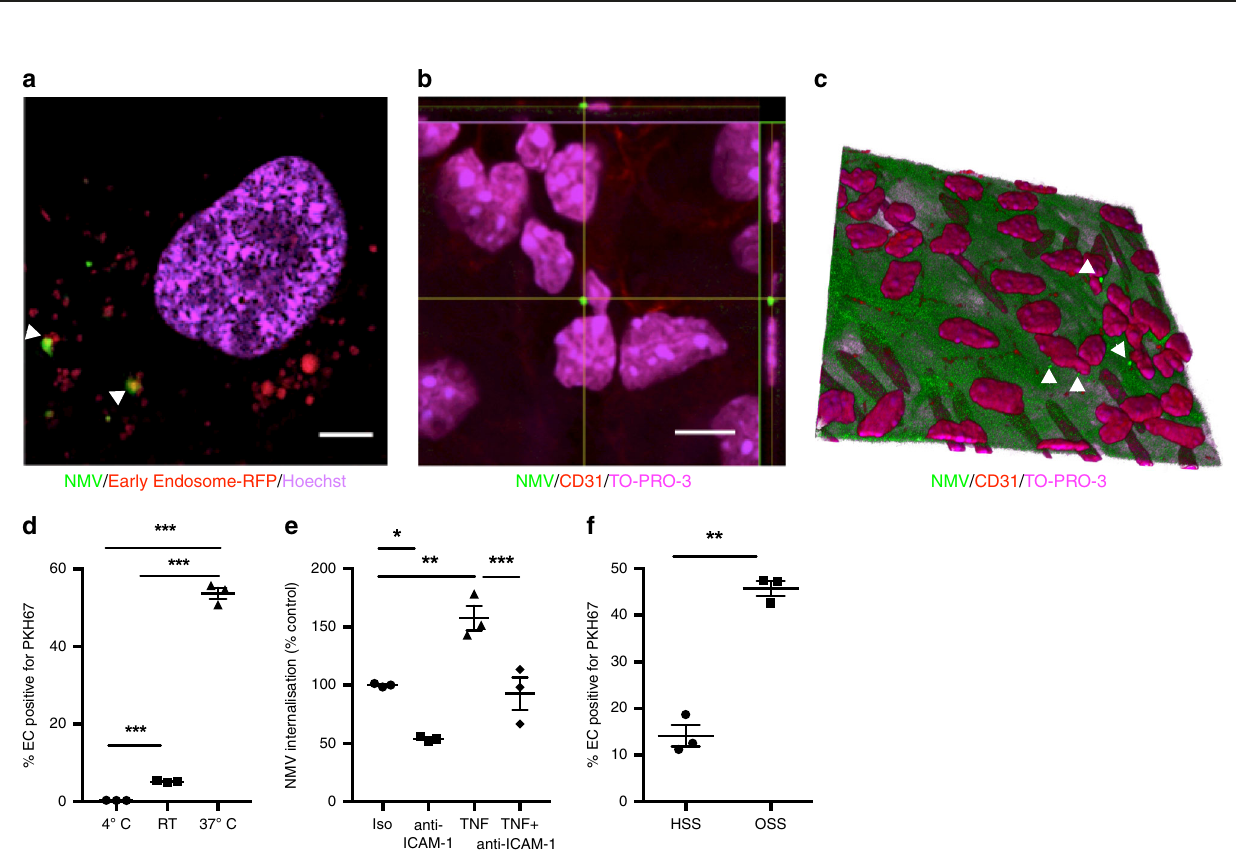
Fig. 4 HCAEC activation by NMVs. HCAEC were cultured for 72 h under static conditions ( a ) or oscillatory shear stress (OSS; b ) and were then incubated with ( + NMV) or without ( − NMV) NMVs for 2 h ( a ; n = 5) and 4 h ( a ; n = 7, b ; n = 4). Release of CCL2, CXCL8 and IL-6 into the media was analysed using cytometric bead array ( a ) or ELISA ( b ). c HCAEC were incubated with ( + NMV) or without ( − NMV) NMVs for 2 h under static conditions and alterations in in fl ammatory protein ( n = 5) expression were investigated using western blotting. Samples were quanti fi ed using densitometry and normalised to GAPDH. d , e HCAEC were incubated with ( + NMV) or without ( − NMV) NMVs for 2 h under static conditions ( n = 10; upper panel) or OSS ( n = 3; lower panel) and gene expression changes measured using RT-qPCR. Samples were normalised to β -actin. Results are presented as mean ± SEM and statistical signi fi cance evaluated using a paired t -test. NS not statistically signi fi cant, * P < 0.05, ** P < 0.01, *** P < 0.001. All n numbers represent independent experiments. Source data are provided as a Source Data fi le.